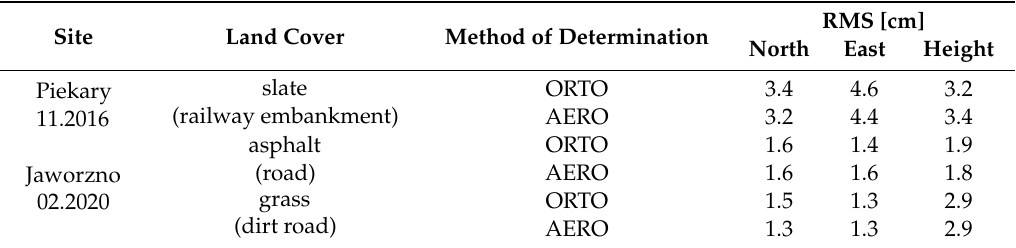
Table 2. RMS coordinate determination